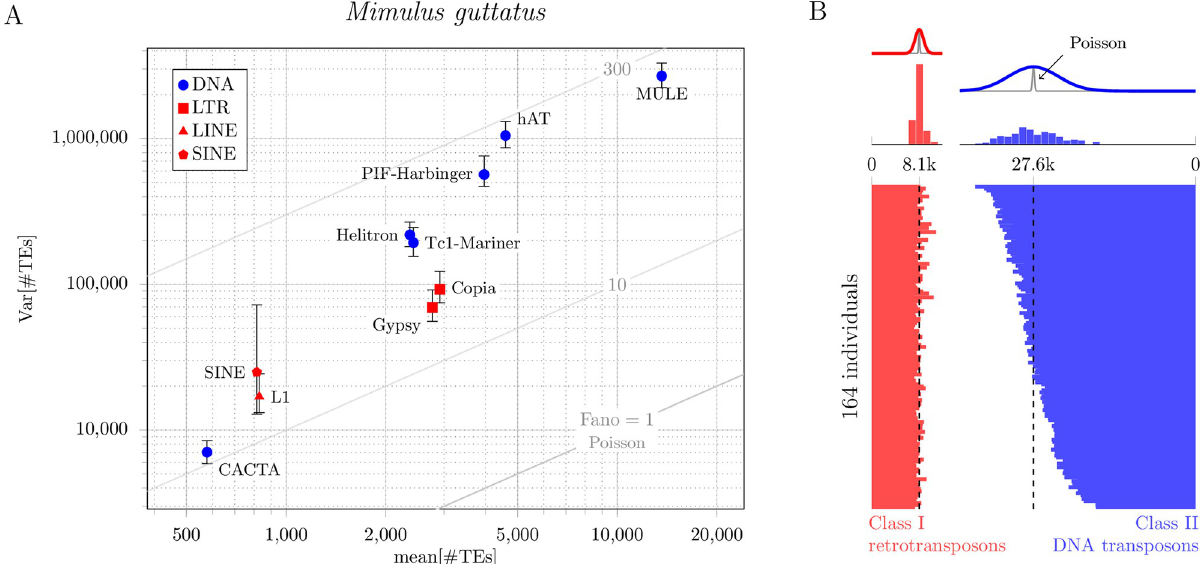
Fig 1. Empirically observed distributions of TE copy number in a Mimulus guttatus population. A: Mean-variance plot of TE copy number for 164 individuals compared to theoretical expectation (Fano = 1, Poisson diagonal line). For each of ten different families of TEs, the index of dispersion is in the range 10 < Fano ½ n � < 300 . For each family, the vertical bars show 95% bootstrap confidence interval of the population variance of TE load. B: TE counts separated by class (red, Class I, retrotransposon; blue, Class II, DNA transposon). The variability in TE load can be observed in the counts from individuals (bottom) as well as histograms (top). Overdispersion is apparent in the deviation of the observed counts (red and blue histograms) from the corresponding Poisson distributions (gray lines). The vertical dashed lines show the population mean of TE load.